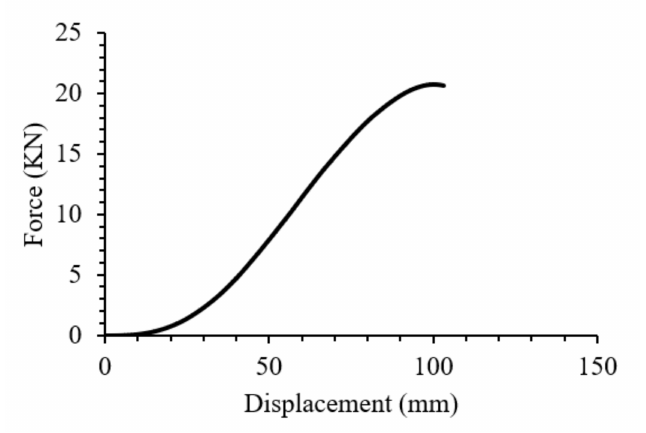
Figure 9. Prediction of the force-displacement behavior of the car door panel made of regenerated cellulose fabric Elium ® composite.